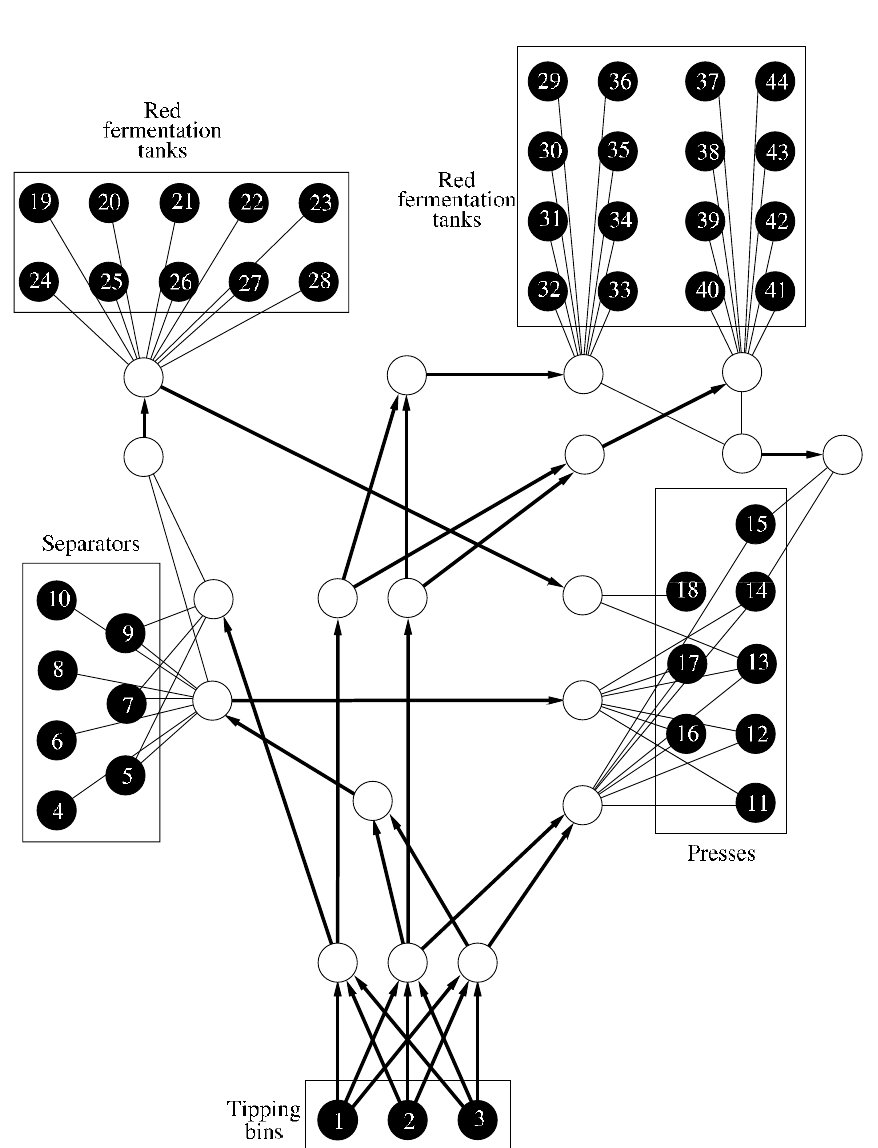
Figure 4: Interconnectivity of the various processors at Wamakersvallei